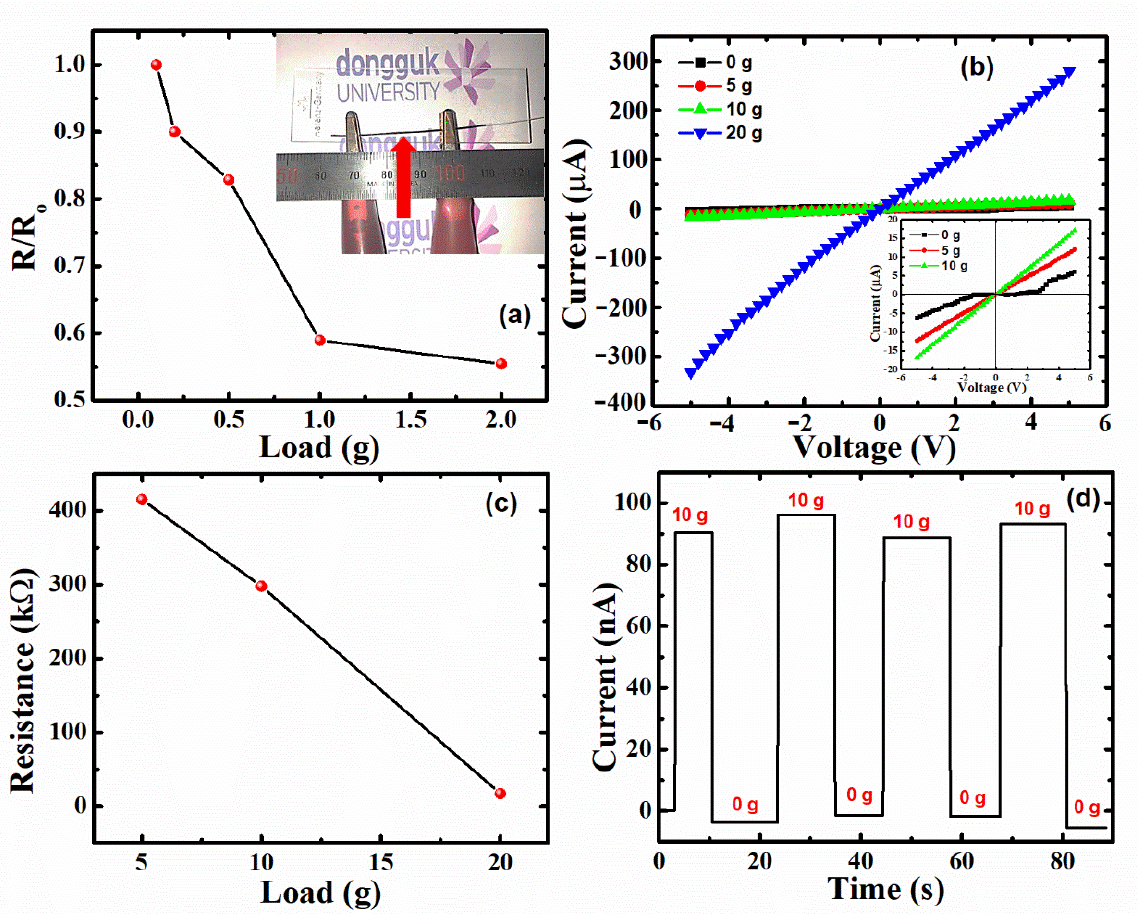
Figure 5. ( a ) The resistance variation while increasing the loading weight from 0.1 g to 2 g on PDMS:Carbon black electrode thin film as shown in the inset, ( b ) I – V curves with varying load from 0 to 20 g with zoomed-in inset figure of 0 – 10 g, ( c ) resistance calculated from the slopes in ( b ) with varying load from 5 – 20 g, and ( d ) the output current with 10 g load for ≈90 s under the short -circuit state.